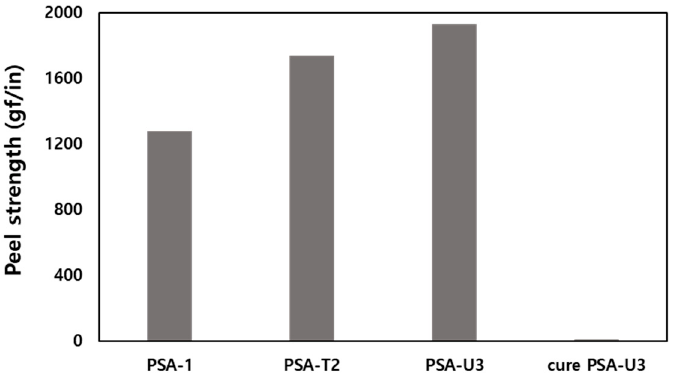
Figure 2. Peel strength of pressure-sensitive adhesive PSA − 1, PSA − T2, PSA − U3, and the cure PSA − U3 tapes .